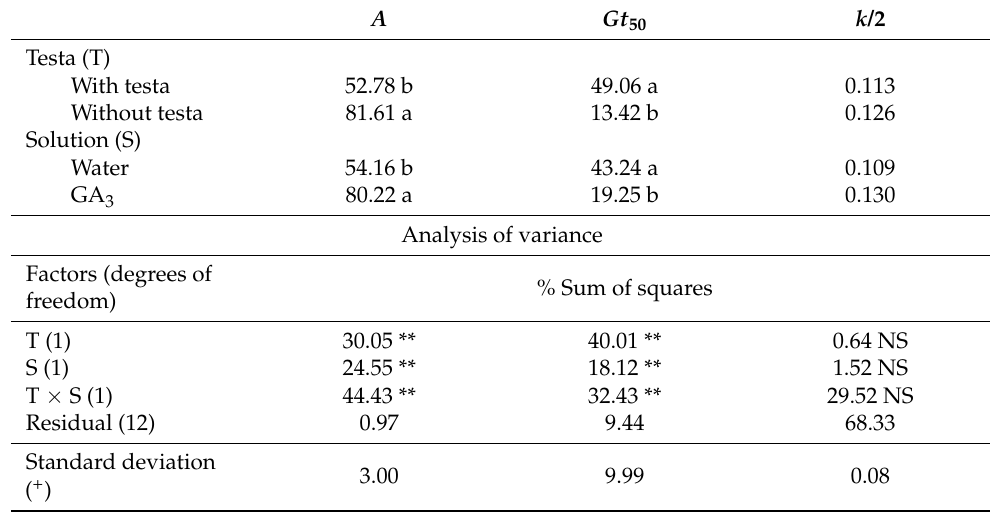
Table 1. Effect of the presence of the testa and the solution used to wet the substrate on the final germination ( A , %), the number of days needed to reach 50% of the final germination ( Gt 5 0 , d) and the relative average rate of accumulated germination ( k /2, d − 1 ). Average values of four replicates.